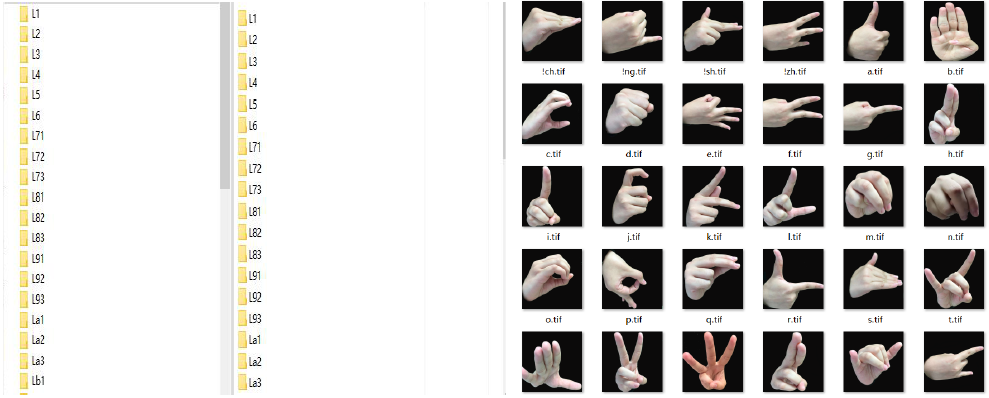
Figure 1. Save images in TIF compression format (Left) and images in L1 folder